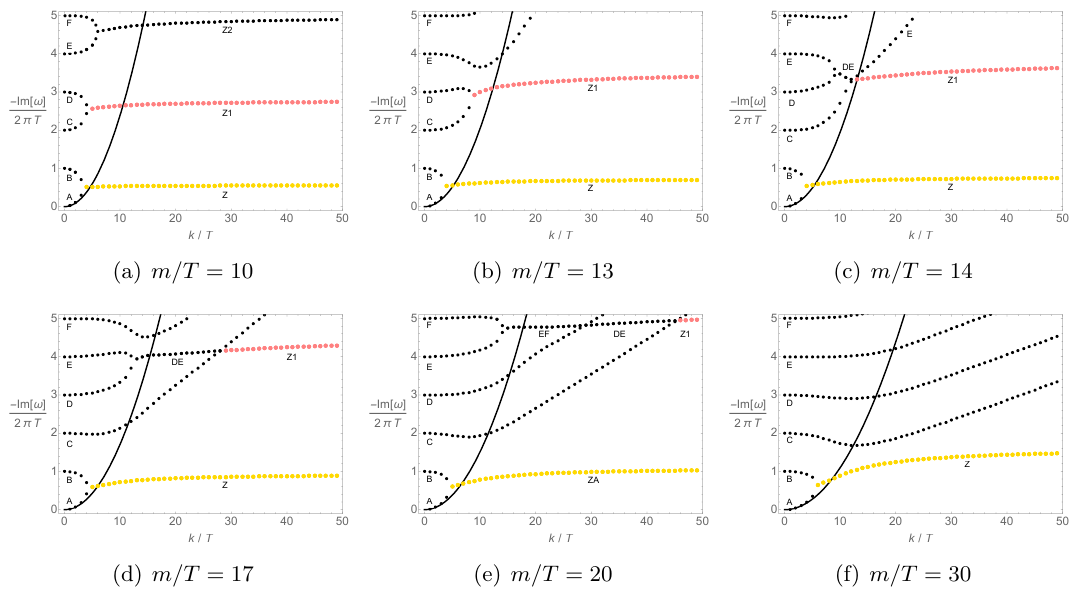
Figure 11 . Quasi-normal modes from high T to intermediate T . DE in figure 11(c) is made by the collision between D and E . EF in figure 11(e) is made by the collision between E and F .